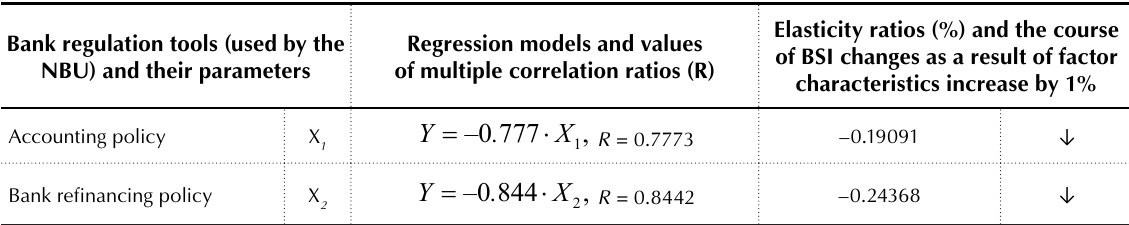
Bank refinancing